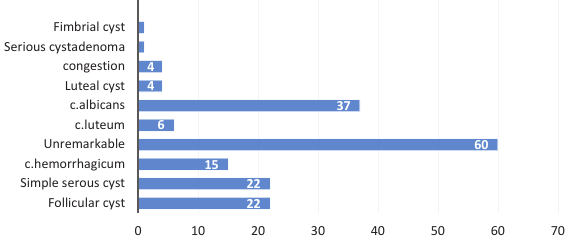
Figure 4. Histopathological Findings of the Ovary. Figure 4.